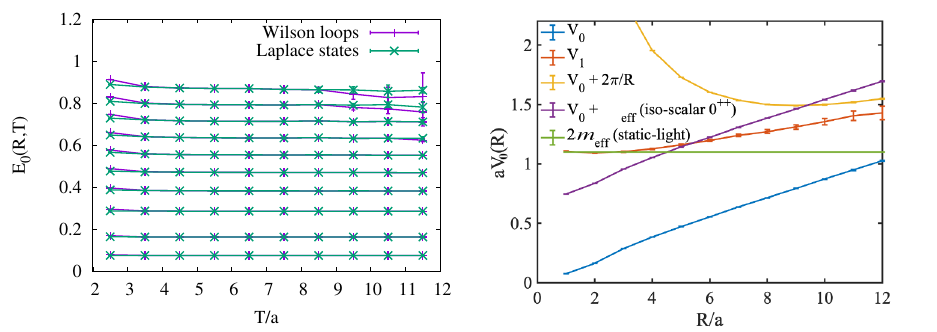
Figure 4. The e ff ective energies / masses (left) using the Laplacian eigenvector approach with Gaussian profiles and Wilson loops with spatial HYP smearing after solving the GEVP, and static potentials V n (right) for the ground ( n = 0) and first excited ( n = 1) states, which we compare with the excited string state V 0 + 2 π/ aR , the lowest 0 ++ iso-scalar meson (possible glueball) state V 0 + am e ff (iso-scalar 0 ++ ) from [26] and two times the static-charm meson mass from